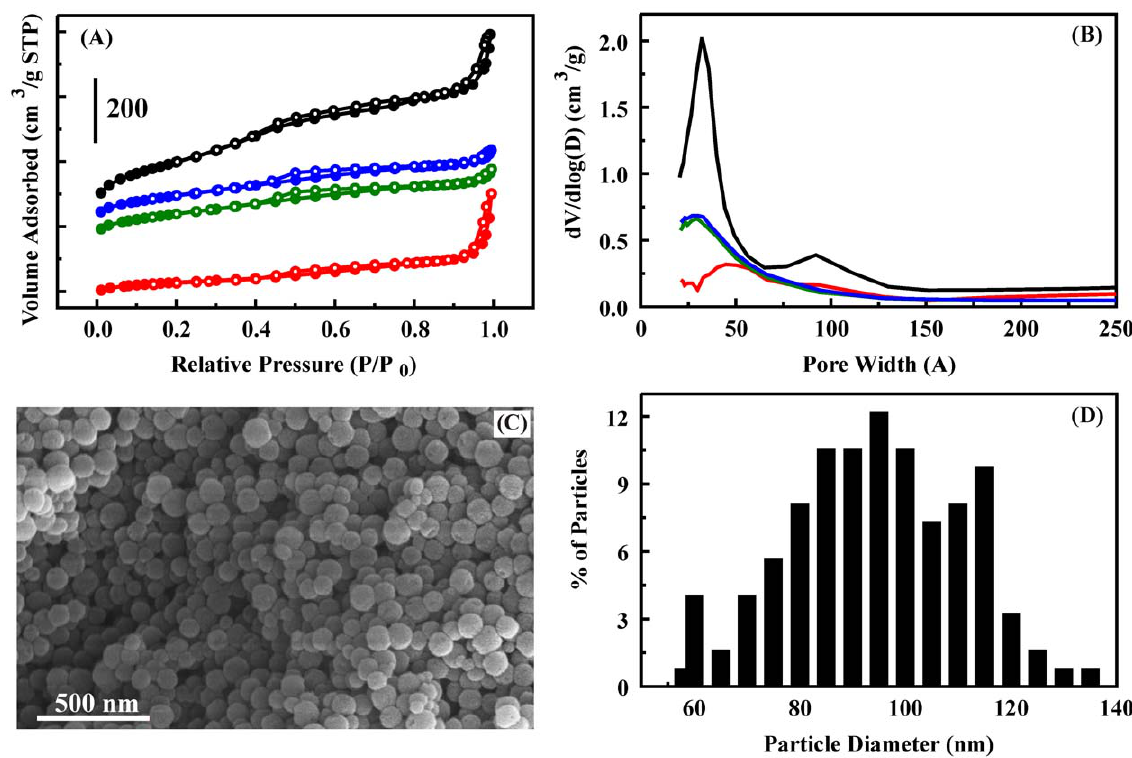
Figure 2. Characterization of nanospherical silicate particles by nitrogen adsorption and SEM imaging: NS (black), NS-G (blue), NS- T (green), and NS-B (red). A. Nitrogen adsorption/desorption isotherms. B. Pore size distributions. C. SEM image. D. Particle diameter distribution determined from SEM images.